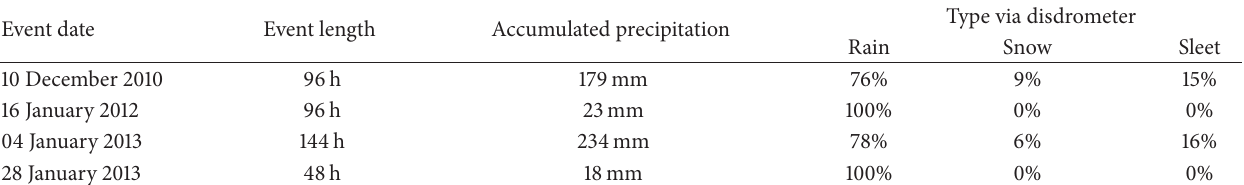
Table 2: Gathered meteorological